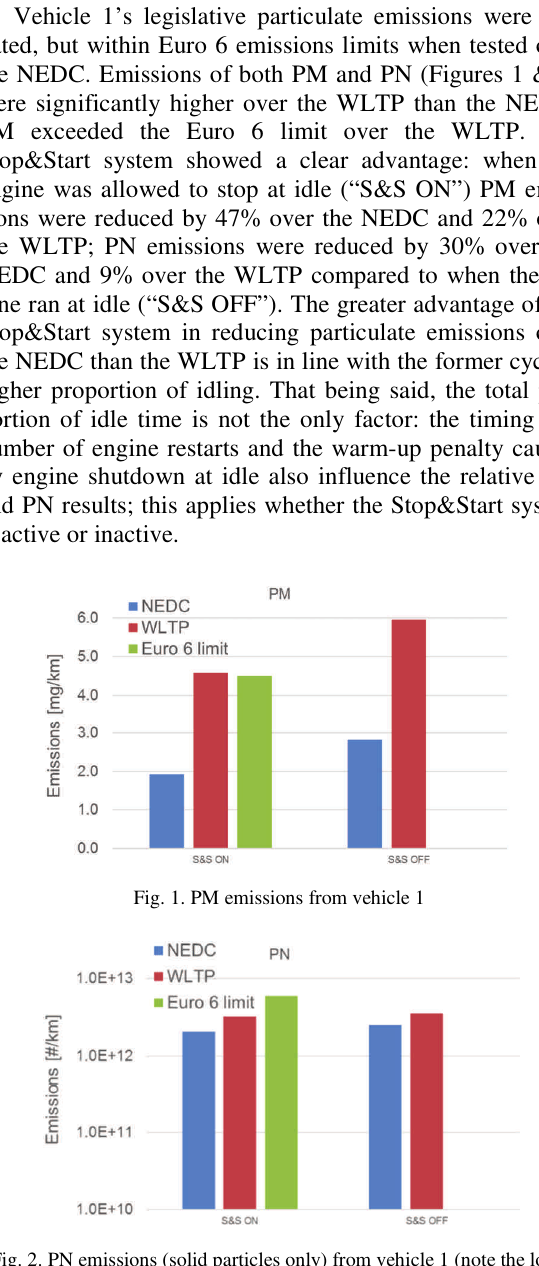
Fig. 2. PN emissions (solid particles only) from vehicle 1 (note the log 10 scale) The magnitude of the emissions from vehicle 1 are rea- sonably similar to those reported elsewhere [7, 15]. Im- portantly, when Stop&Start was turned on, the vehicle met the Euro 6 PN limit over the WLTC, despite (presumably) not being calibrated to that